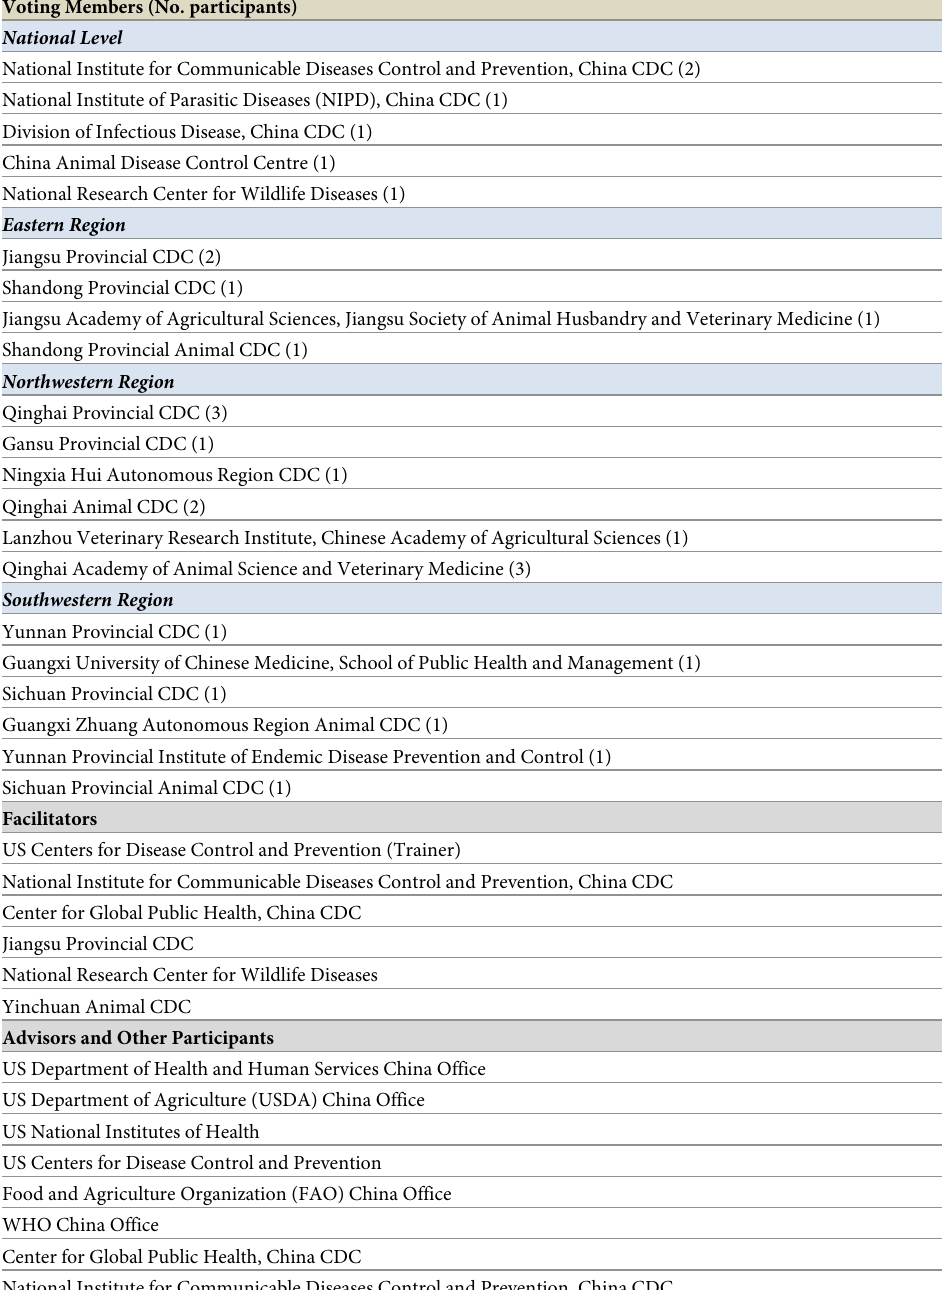
Table 1. Agencies participating in the one health zoonotic disease prioritization workshop, Beijing, China, May 15–17, 2019. Voting Members (No.